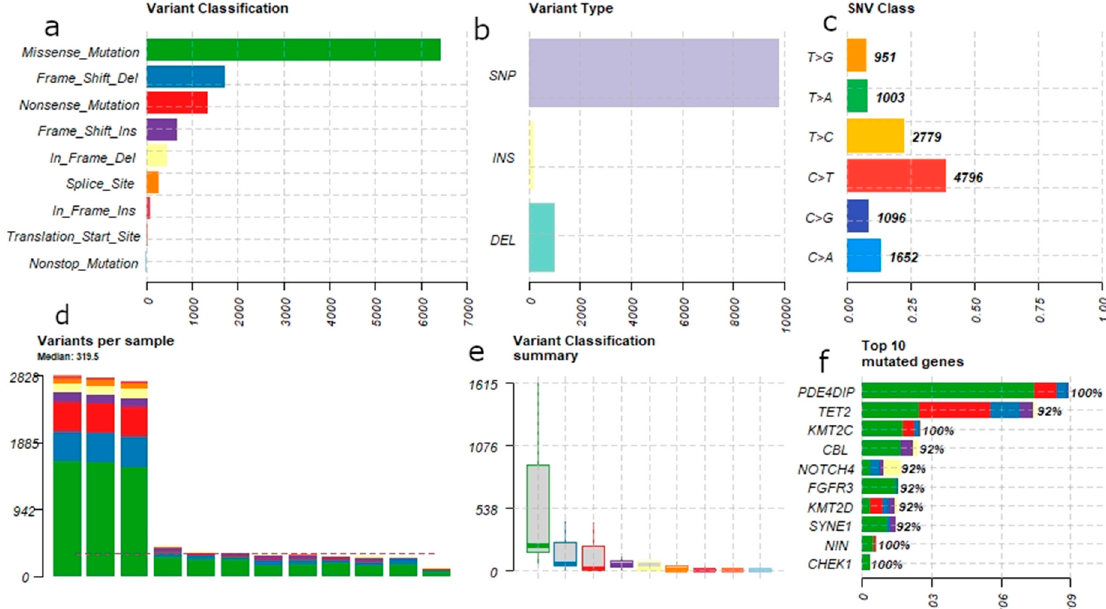
Figure 1. Summary of somatic mutations in 12 B-ALL patients. Six panels above describe the variant classification, variant type, SNV class, variant per sample, variant classification summary and top 10 mutated genes. Missense mutations are the most common form of mutations ( a ). Single nucleotide polymorphism (SNP) is the most common genetic variant type ( b ). Among single nucleotide variation (SNV) transition, C > T is the most common ( c ). ( d ) represents the mutational load per sample. The variant classification summary ( e ) represents box plot of the numbers across the 12 B-ALL patients. At the end, the most frequently mutated genes have been shown across the cohort ( f